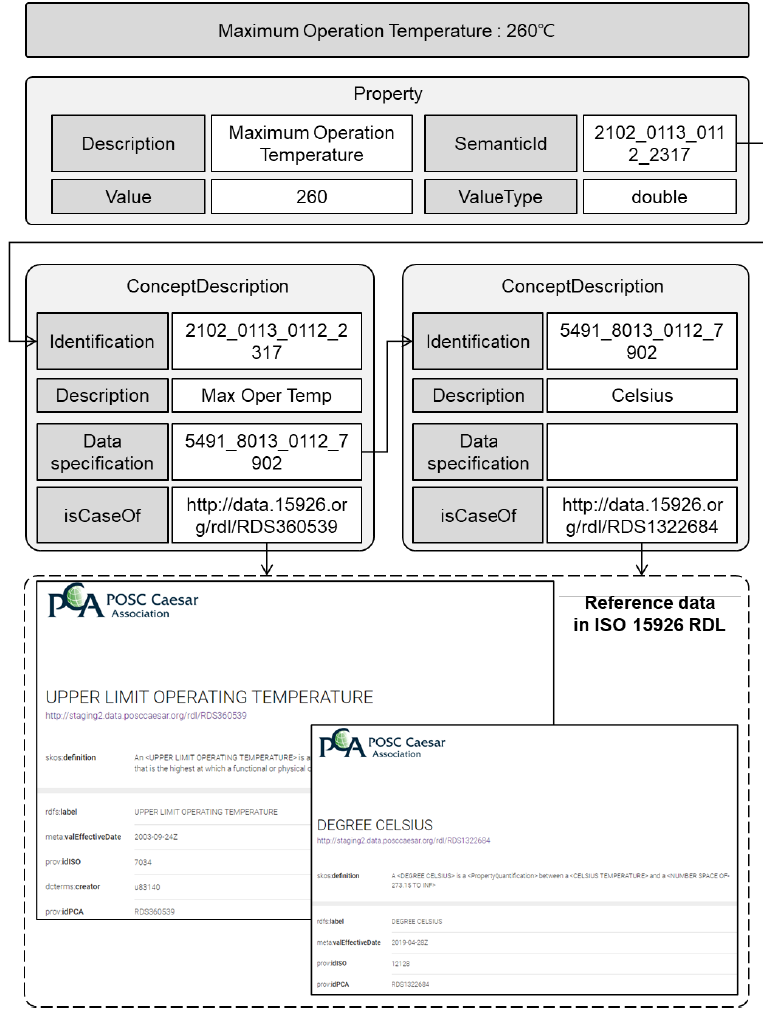
Figure 10. Connection between ISO 15926 reference data and an AAS-based neutral model.